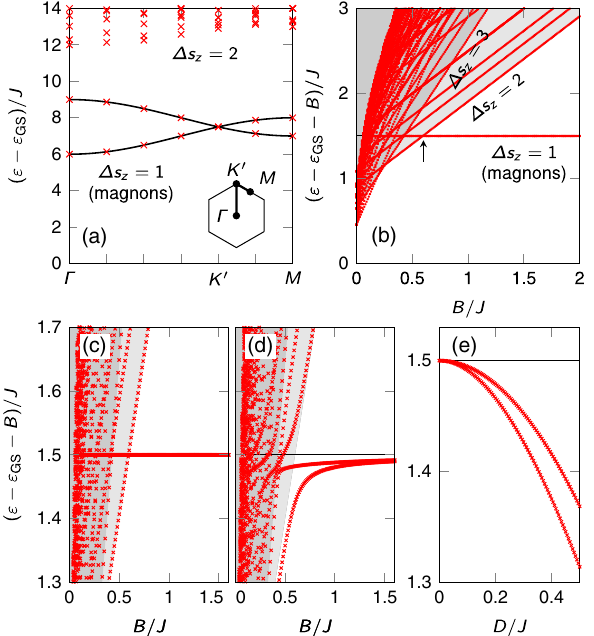
FIG. 17. Spectrum of the chiral magnet obtained from ED in the quantum limit of S ¼ 1 = 2 . Energies are given with respect to the ground-state energy ε . (a) Momentum dependence of the GS spectrum for D=J ¼ 0 at B=J ¼ 6 , causing an energetic sepa- 1 excitations (magnons) and higher-spin ration between Δ s z ¼ plotted.FIG. 16. Interaction-induced transverse thermal conductivity excitations. Black lines indicate the spin-wave spectrum given in κ 3 D κ 3 D ; nominal κ 3 D ; correction Eq. (12), and the inset shows the hexagonal Brillouin zone with a xy þ xy [see Eq. (49)] as a function of xy ¼ highlighted path connecting high-symmetry points. (b) Field temperature for selected magnetic field values B=J . (a) The dependence of the spectrum at the K (or K 0 ) point, at which the ˜ L ð 2 Þ nominal contribution κ 3 D ; nominal xy shows the same features as xy Δ s 1 excitations (magnons) are degenerate for D=J ¼ 0 . Note z ¼ [cf. Fig. 15], i.e., a sign change with both magnetic field and − B Þ =J , such that Δ s 1 that the ordinate shows ð ε − ε z ¼ GS temperature. (b) The correction term κ 3 D ; correction xy has a sign excitations appear as a horizontal line and only higher-spin opposite to that of the nominal contribution and is of the same excitations (indicated by gray continua) shift with increasing exhibits magnitude. (c) The total thermal Hall conductivity κ 3 D JS ¼ 0 . 5 (see arrow), the field. For fields just above B xy c ¼ Δ s 1 excitations cut into the Δ s 2 excitations. Eigenstates features identical to that of κ 3 D ; nominal xy , but its magnitude is z ¼ z ¼ reduced. The inset shows κ 3 D for fields B=J > 1 . For each with different spin quantum numbers do not hybridize because of xy the absence of DMI. (c) Zoom in of the energy and field window, magnetic field value, we define an upper threshold temperature 1 and Δ s 2 excitations overlap. within which the Δ s T ⋆ by M ð T ⋆ Þ ¼ 0 . 5 [see Eq. (43) and Fig. 14]. For T < T ⋆ , the z ¼ z ¼ (d) Same as panel (c) but with finite DMI D=J ¼ 0 . 15 , causing spin-wave theory carried out in this paper is expected to be a spin nonconservation and a hybridization between different spin good approximation. In contrast, temperatures T > T ⋆ require 1 excitations sectors. Importantly, the formerly degenerate Δ s higher-order spin-wave corrections. The parameters are S ¼ 1 z ¼ 2 get gapped. This gap increases the closer they get to the Δ s and D=J ¼ 0 . 15 z ¼ 1 excitations as a function excitations. (e) Splitting of the Δ s z ¼ of DMI at B=J ¼ 1 . For all simulations, a cluster of 24 spins was considered. In panels (b) – (d), the lowest 100 eigenvalues are